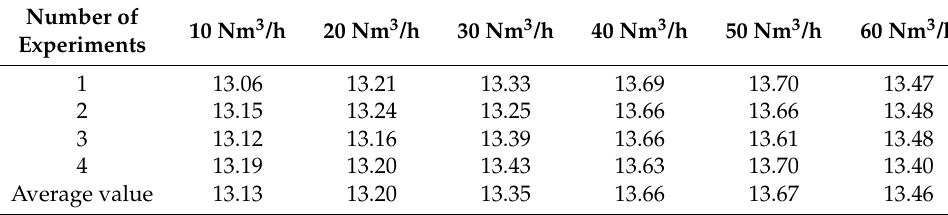
Table 13. Liquid particle size in Case 3 at M 2 ( µ m).